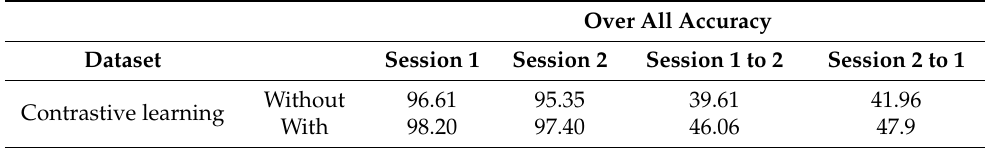
Table 8. Sensitivity with respect to the contrastive loss module.